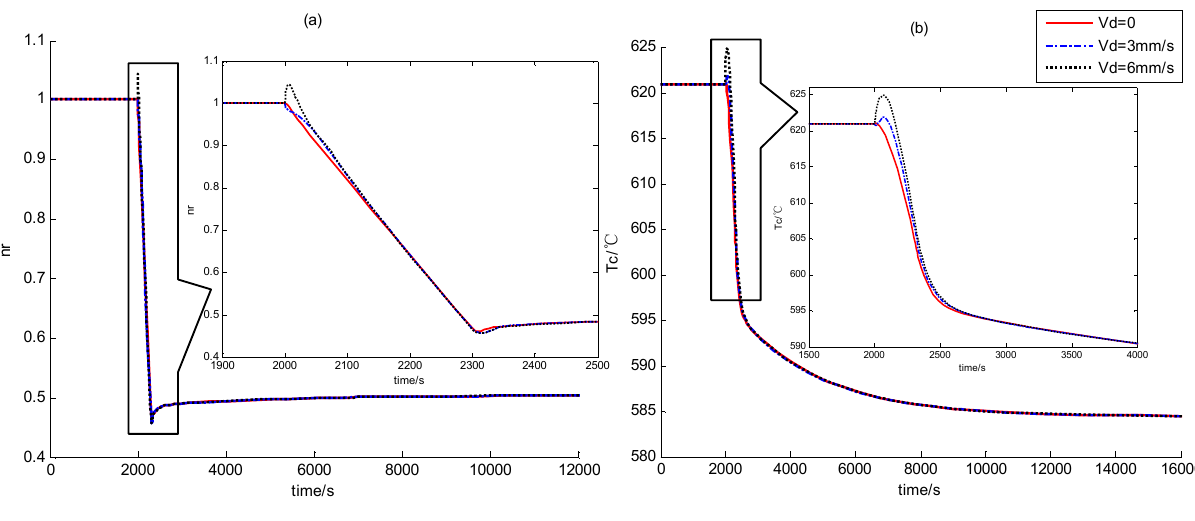
Figure 3. Power drop controlled by feedback dissipation PLC. ( a ) Relative nuclear power-level; ( b ) Average temperature of fuel elements; ( c ) Outlet helium temperature of the reactor; ( d ) Control rod speed